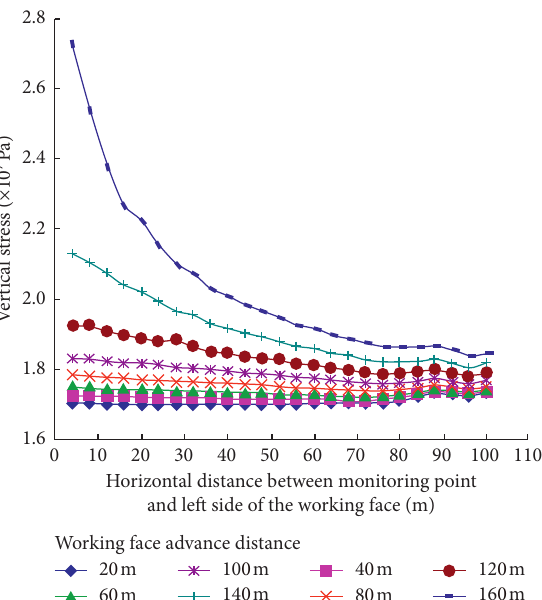
Figure 9: Vertical stress variation of each monitoring point at different advance distance of the working